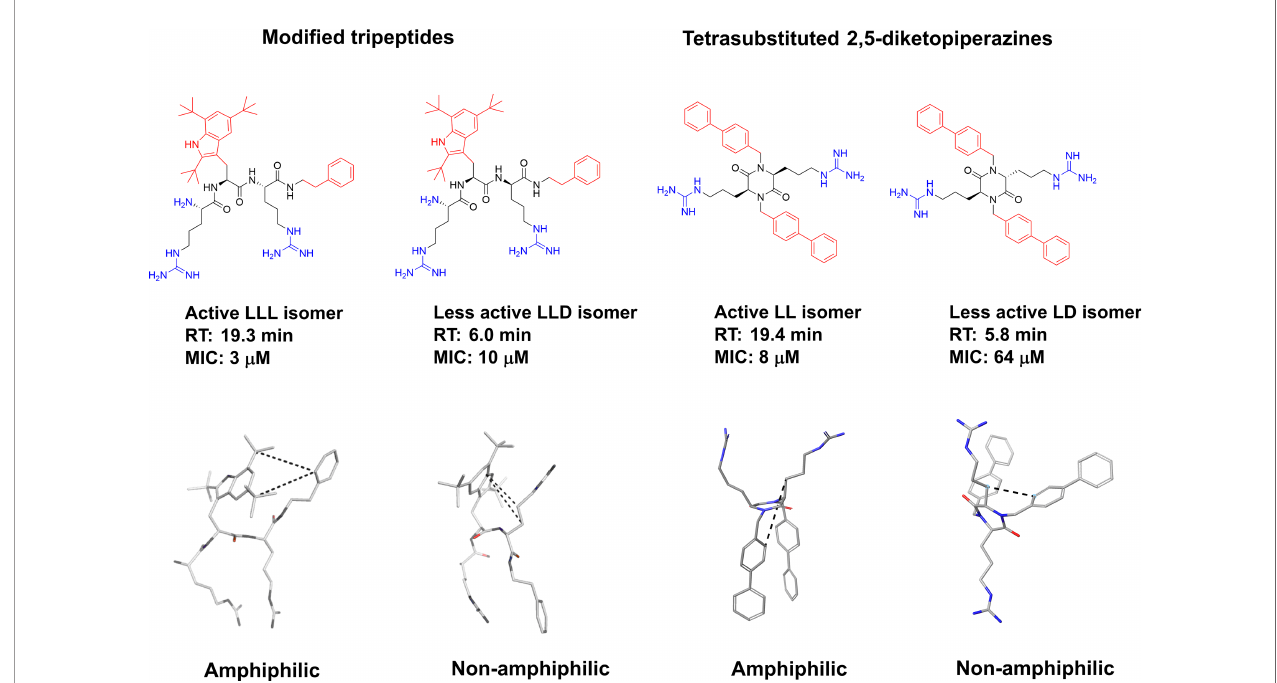
FIGURE 14 | Graphical illustration of the role of stereochemistry on structure and antimicrobial activity of short, modi fi ed tripeptidic AMPs and tetrasubstituted 2,5- DKP. Making mixed analogs disrupted the amphiphilicity and creates more hydrophilic and less activity compounds (93, 166). Bottom left structures of LTX-109 are reprinted with permission from Isaksson et al (166). J Med Chem 2011 Vol. 54 Issue 16 Pages 5786-95. Copyright 2011 American Chemical